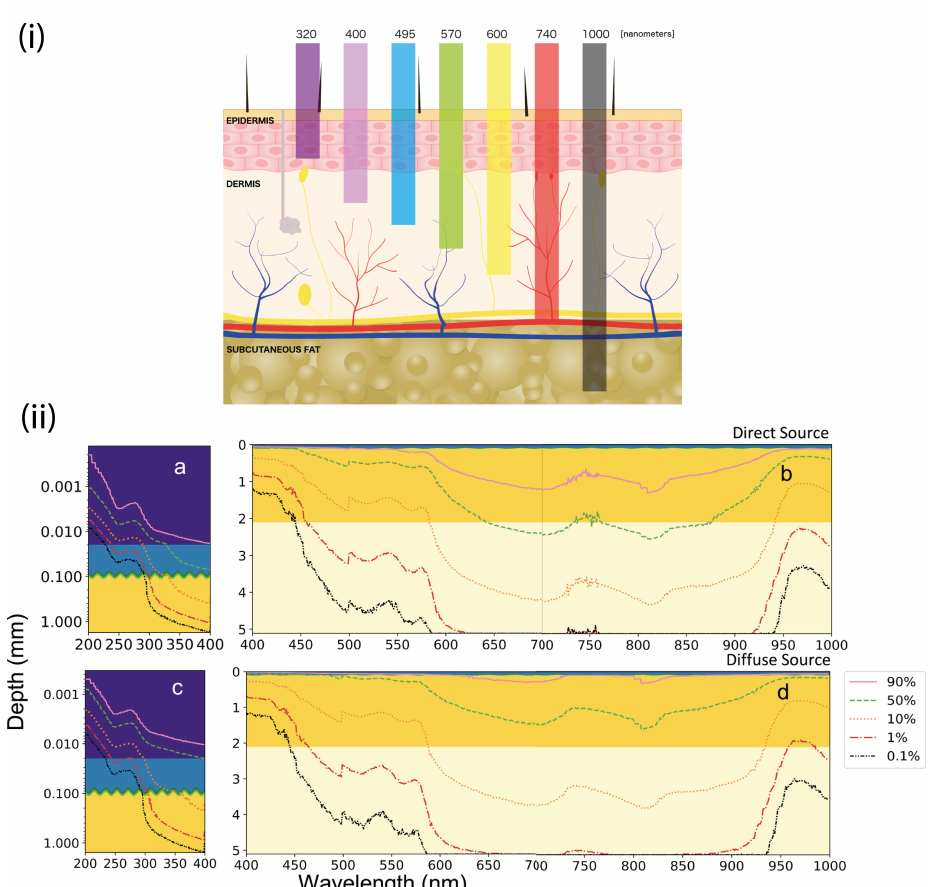
Figure 8. Skin tissue penetration under different wavelengths of light. ( i ) As the wavelength increases, the depth of light travel also increases. In the visible spectrum, red light penetrates the most at around 5 mm under the skin [199]. Reproduced under the terms of CC-BY license ( ii ) Plots illustrating the depth into the skin as a function of wavelength at which the fluence rate approaches 90%, 50%, 10%, 1%, and 0.10% of the incident light value. The response penetration is shown for direct source incident light of ( a ) 200–400 nm and ( b ) 400–1,000 nm wavelengths. Similarly, for diffuse source light response to penetration of wavelengths ( c ) 200–400 nm, and ( d ) 400–1000 nm is depicted [200]. Dark blue: stratum corneum layer, sapphire blue: epidermis layer, dark green: melanin layer, light green: basal layer, dark yellow: dermis layer and light yellow: subcutaneous fat. Reproduced under the terms of the CC-BY